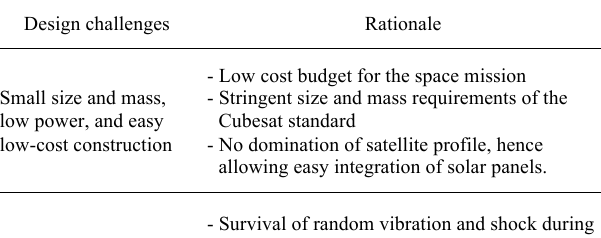
Table I. Cubesat antenna system design challenges